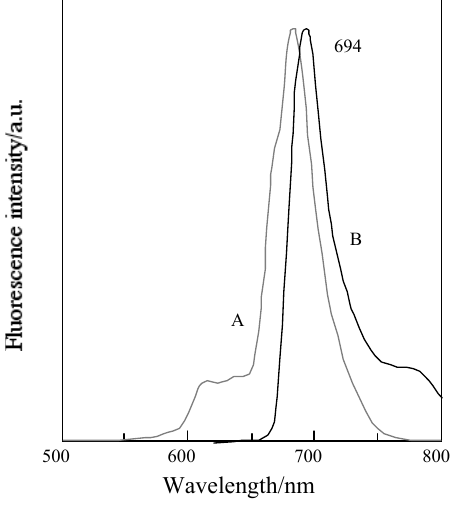
Figure 17. Fluorescence and excitationspectra of 5c in DMF. A; Excitation spectrum, B; Fluorescence